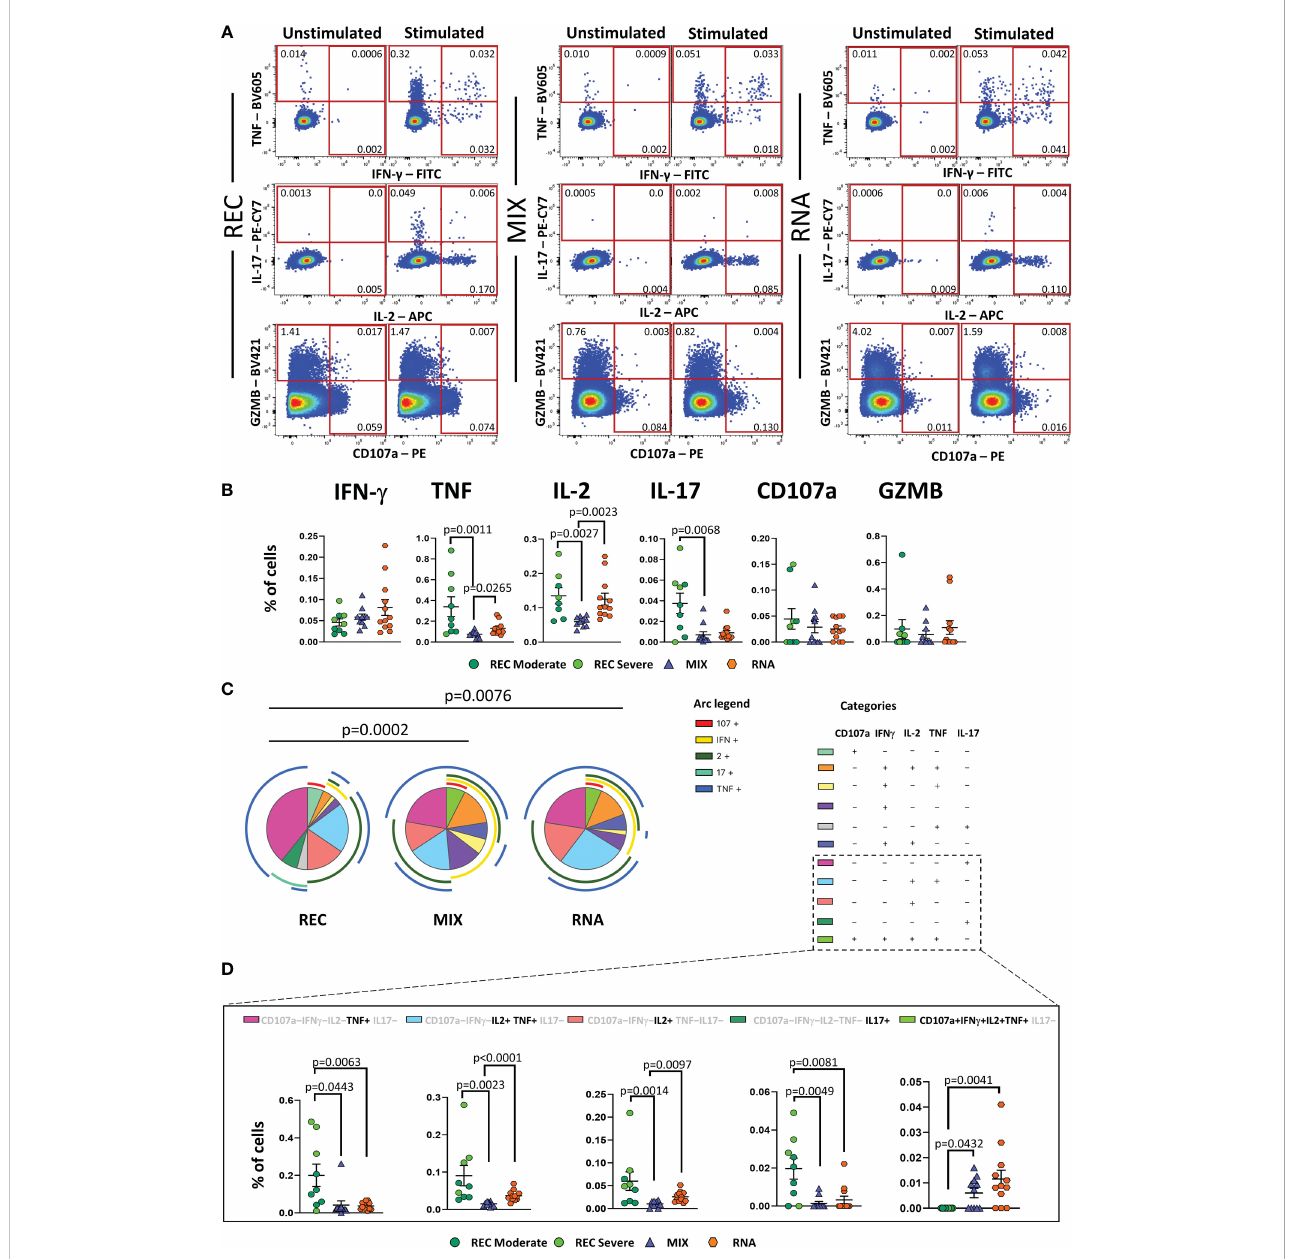
FIGURE 3 Cytokine production and polyfunctionality of antigen-speci fi c CD4 + T cells. (A) Representative dot plots showing manual gating analysis of intracellular cytokine production of CD4 + T lymphocytes after overnight stimulation with spike protein compared to unstimulated control. Numbers in the dot plots indicate the percentage of cells identi fi ed by the gates. (B) Comparison between the total production of IFN- g , TNF, IL-17, IL-2, CD107a, and GZMB by CD4 + T cells after in vitro stimulation with 15-mer peptides, covering the complete sequence of Wuhan SARS-CoV-2 spike glycoprotein. Data represent individual values from nine healthy subjects who recovered from SARS-CoV-2 infection (REC, severe = 4 and moderate = 5) and 23 vaccinated donors (MIX= 11 and RNA = 12). Mean (center bar)±SEM (upper and lower bars). Kruskal – Wallis test with Benjamini – Hochberg correction for multiple comparisons was used to test the differences among the three groups. (C) Pie charts representing the proportion of responding CD4 + T cells producing different combinations of CD107a, IL-2, IL-17, IFN- g , and TNF after in vitro stimulation with 15-mer peptides, covering the complete sequence of Wuhan SARS-CoV-2 spike glycoprotein. Frequencies were corrected by background subtraction as determined in non-stimulated controls using SPICE software. Pie arches represent the total production of different cytokines. (D) Percentage of polyfunctional population within CD4 + T cells. Kruskal – Wallis test with Benjamini – Hochberg correction for multiple comparisons was used to test the differences among the three groups. Adjusted P-values are indicated in the fi